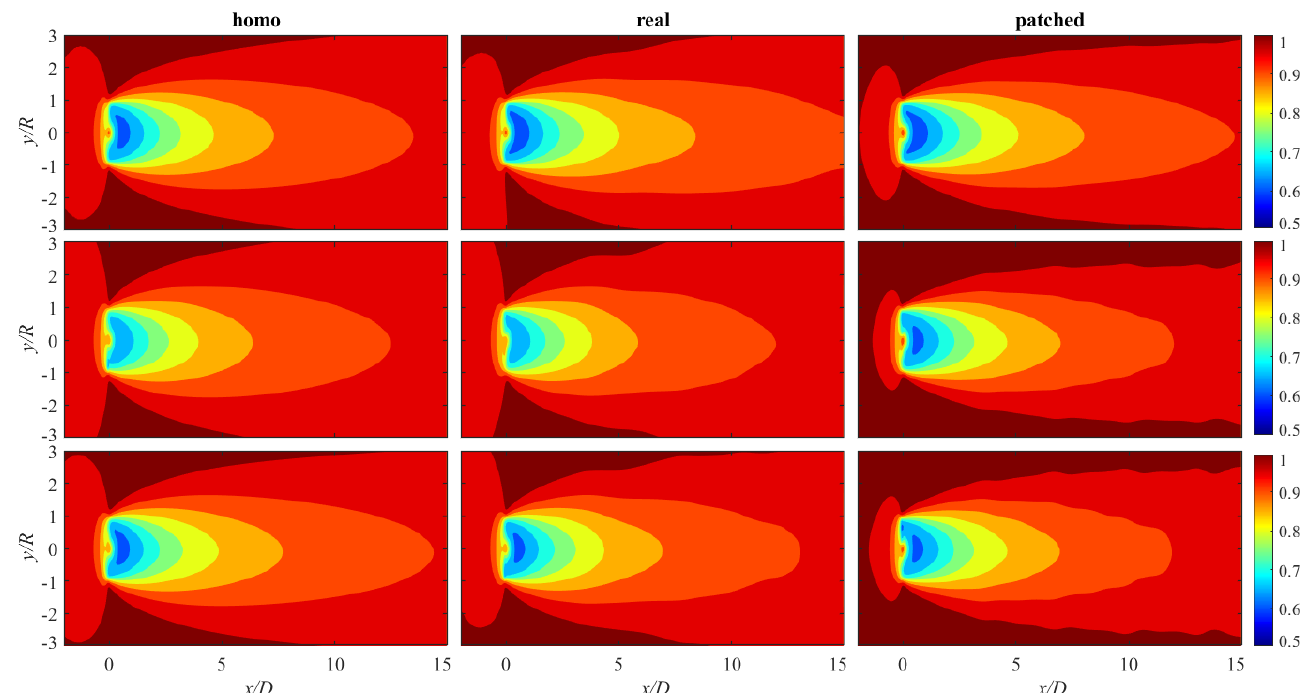
Figure 22. Wake transition of the velocity deficit ( ∆ U ) ( up ) and TKE increase ( ∆ k ) ( down ) taken from the horizontal line at the hub height.